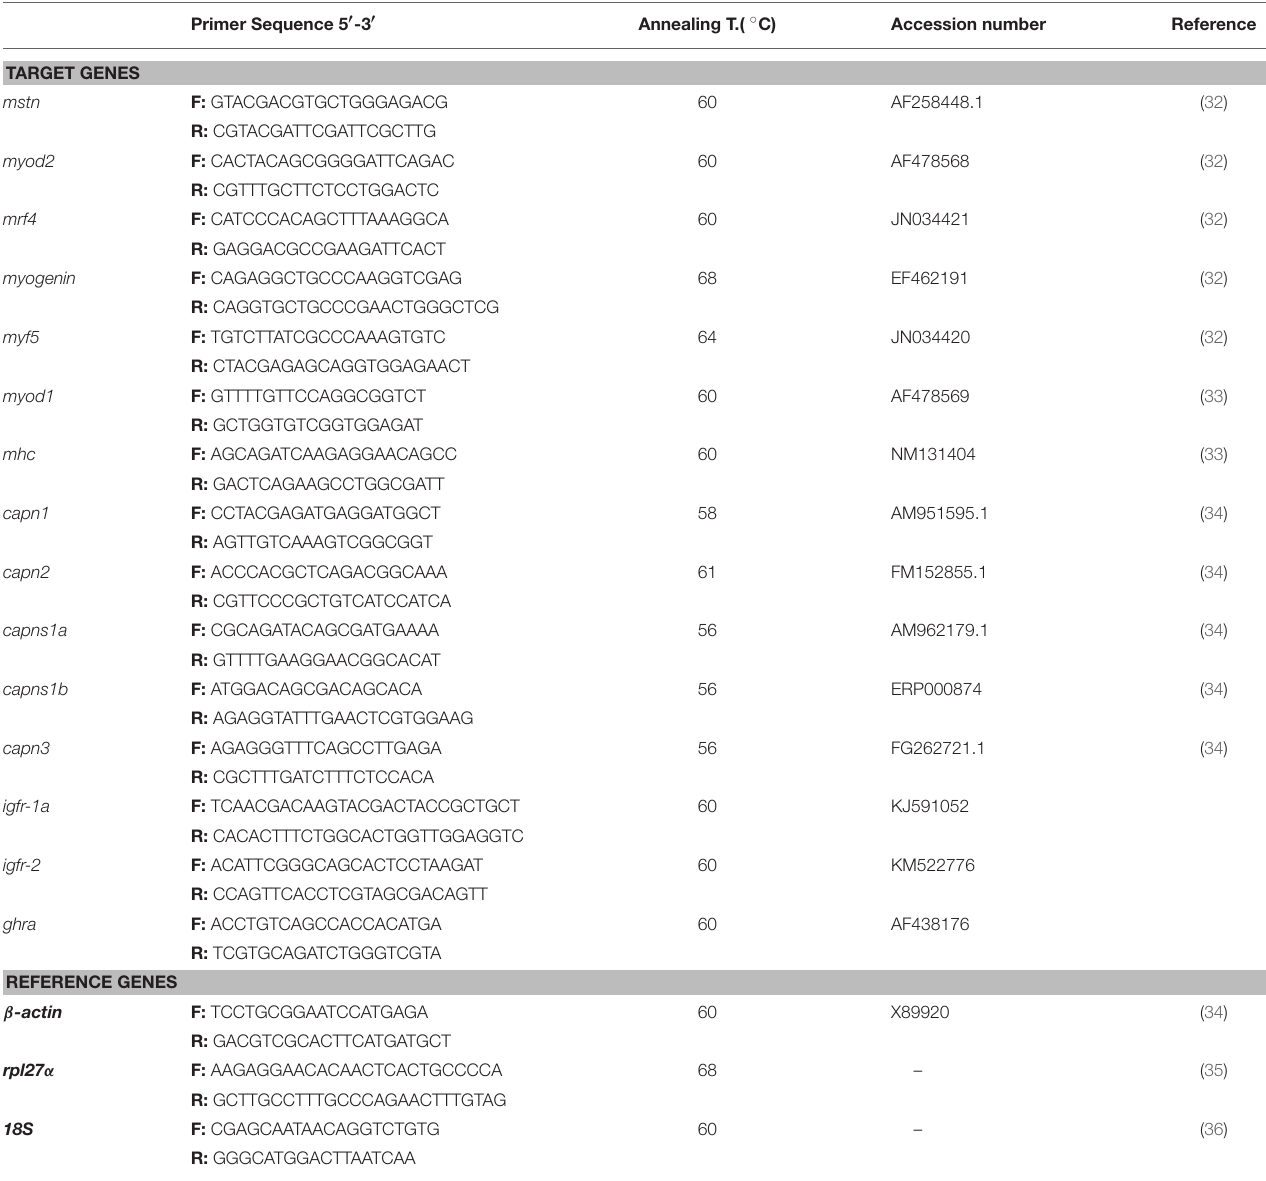
TABLE 2 | List of specific primers used for real time PCR. Primer Sequence 5 ′ -3